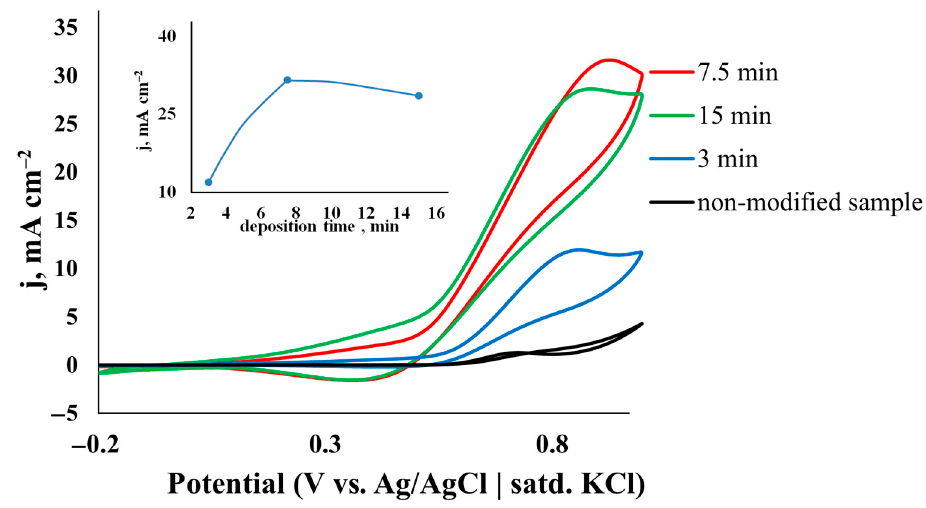
Figure 5. CV of copper catalysts manufactured by electrodeposition at − 5 A m − 2 and KBr concentration of 1 g L − 1 for 3.0, 7.5, and 15 min. Inset: plot of anodic peak current versus copper deposition time.